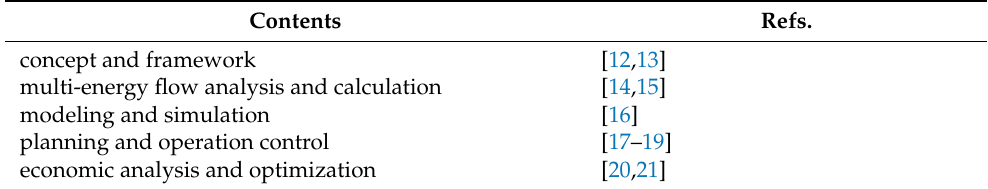
Table 1. Relevant studies on integrated energy